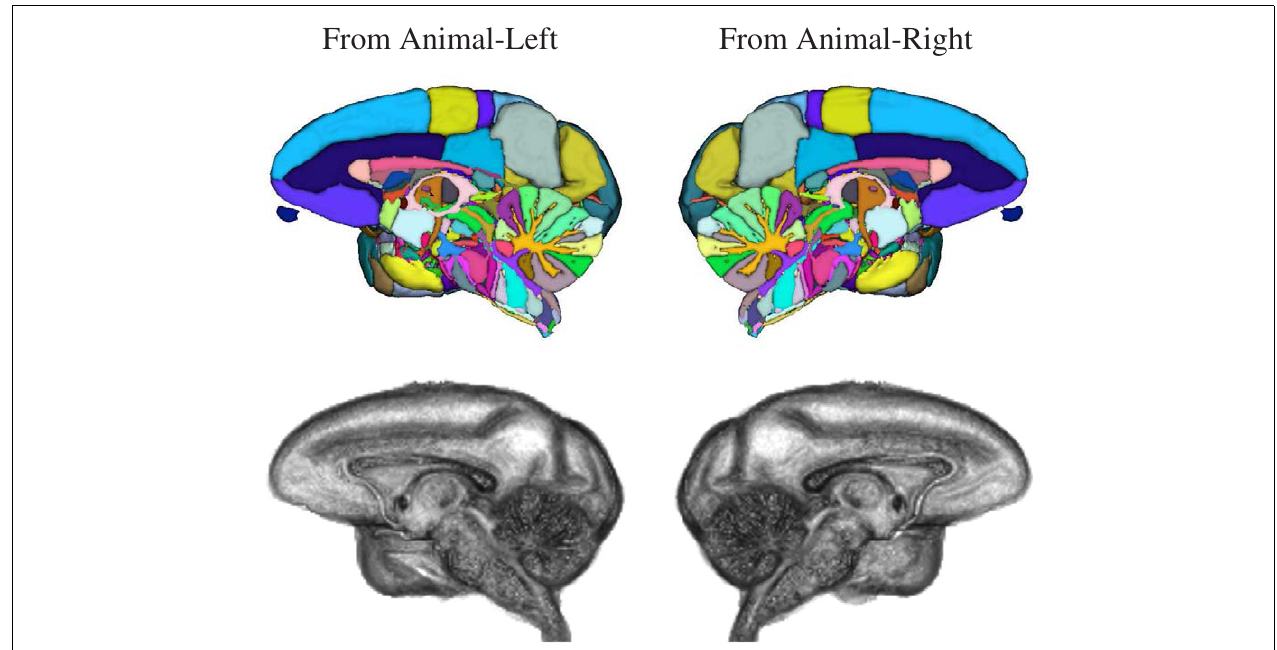
FIGURE 8 |Three-dimensional volume renderings of theT1-weighted INIA19 brain template image (gray) and surface renderings of the NeuroMaps label map after mapping into INIA19 space (colors), each cut at the midsagittal plane to reveal the proximal surface of the opposite hemisphere.